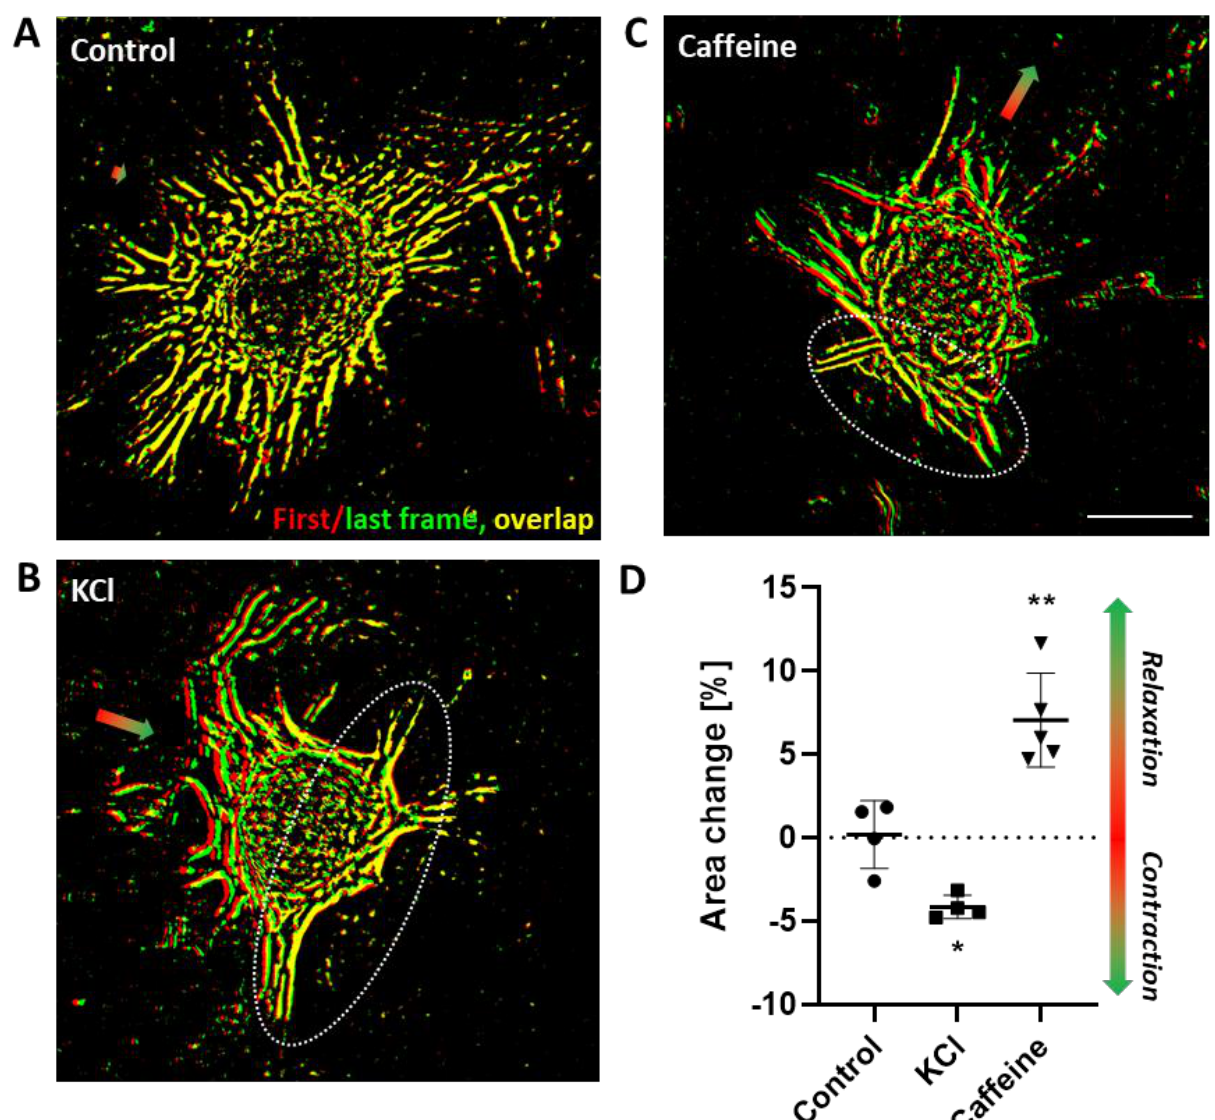
Figure 2. In vitro contraction/relaxation assay. ( A – C ) Representative images showing structural segments (computer-assisted detection) of aoSMC spheroids attached to collagen type I hydrogels before (red) and after (green) being stimulated with solvent (( A ), control), potassium chloride (( B ), KCl, 60 mM) or caffeine (( C ), 10 mM, scale bar: 100 µm). The dotted circle defines the area that serves as ‘anchor’ for the contracting/relaxing spheroid. Colored arrows indicate the accumulated movement vector of the cellular segments in relation to the anchor point. ( D ) Quantification of area changes (see Figure S3) of aoSMC spheroids upon exposure to the stimuli (n = 4 – 5, * p < 0.05, ** p < 0.01).